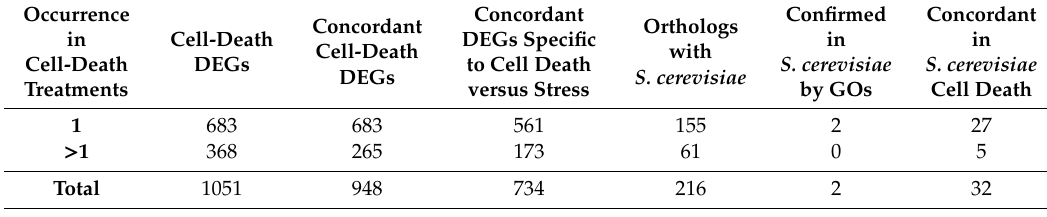
Table 2. Number of H. sapiens cell-death candidate DEGs. Numbers based on the analysis of the orthologs with S. cerevisiae cell-death DEGs are included. The number of H. sapiens cell death candidate DEGs (cell-death DEGs), of the DEGs that had the same pattern of expression in H. sapiens cell death experiments (concordant cell-death DEGs), the concordant DEGs of H. sapiens with expression patterns specific to cell death (concordant DEGs specific to cell death versus stress), the number of orthologs with S. cerevisiae , their number when compared with S. cerevisiae DEGs having a GO related to cell death or autophagy (confirmed in S. cerevisiae by GO), and the number when considering S. cerevisiae DEGs with the same expression patterns (concordant in S. cerevisiae cell death), are all reported.